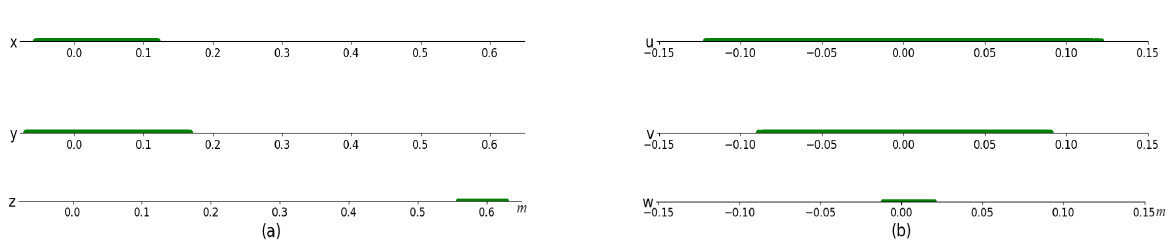
Figure 3. Projection of point cloud data onto the coordinate system. ( a ) Distribution map of the point cloud in the original coordinate system ( x , y , z ) . ( b ) Distribution map of the point cloud in the reconstructed coordinate system ( u , v , w ) . Algorithm 1 used the PCA algorithm to reconstruct the coordinate system ( u , v , w ) for obtaining the range of interest (RoI) of leaf and the key points of length and